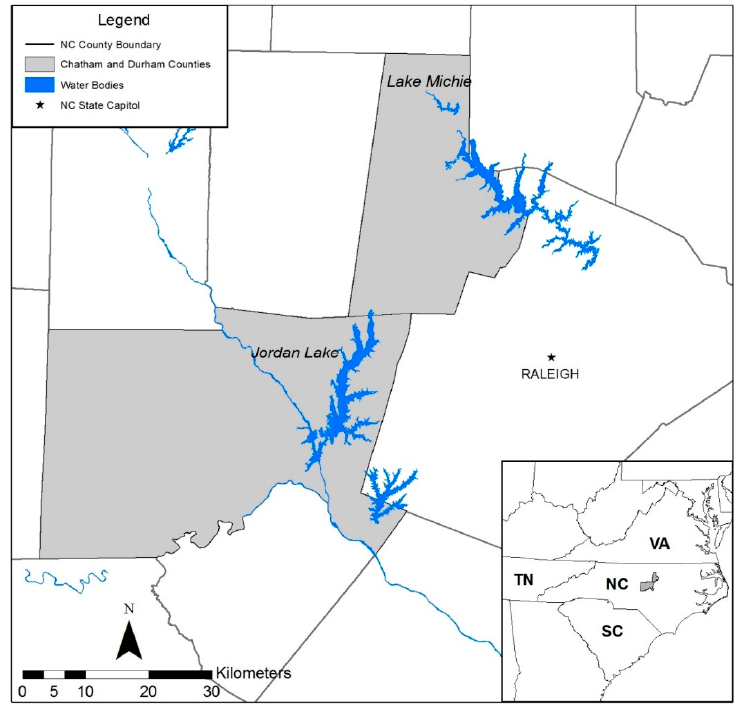
Figure 1. Map depicting the study sites, Jordan Lake and Lake Michie in North Carolina, USA.